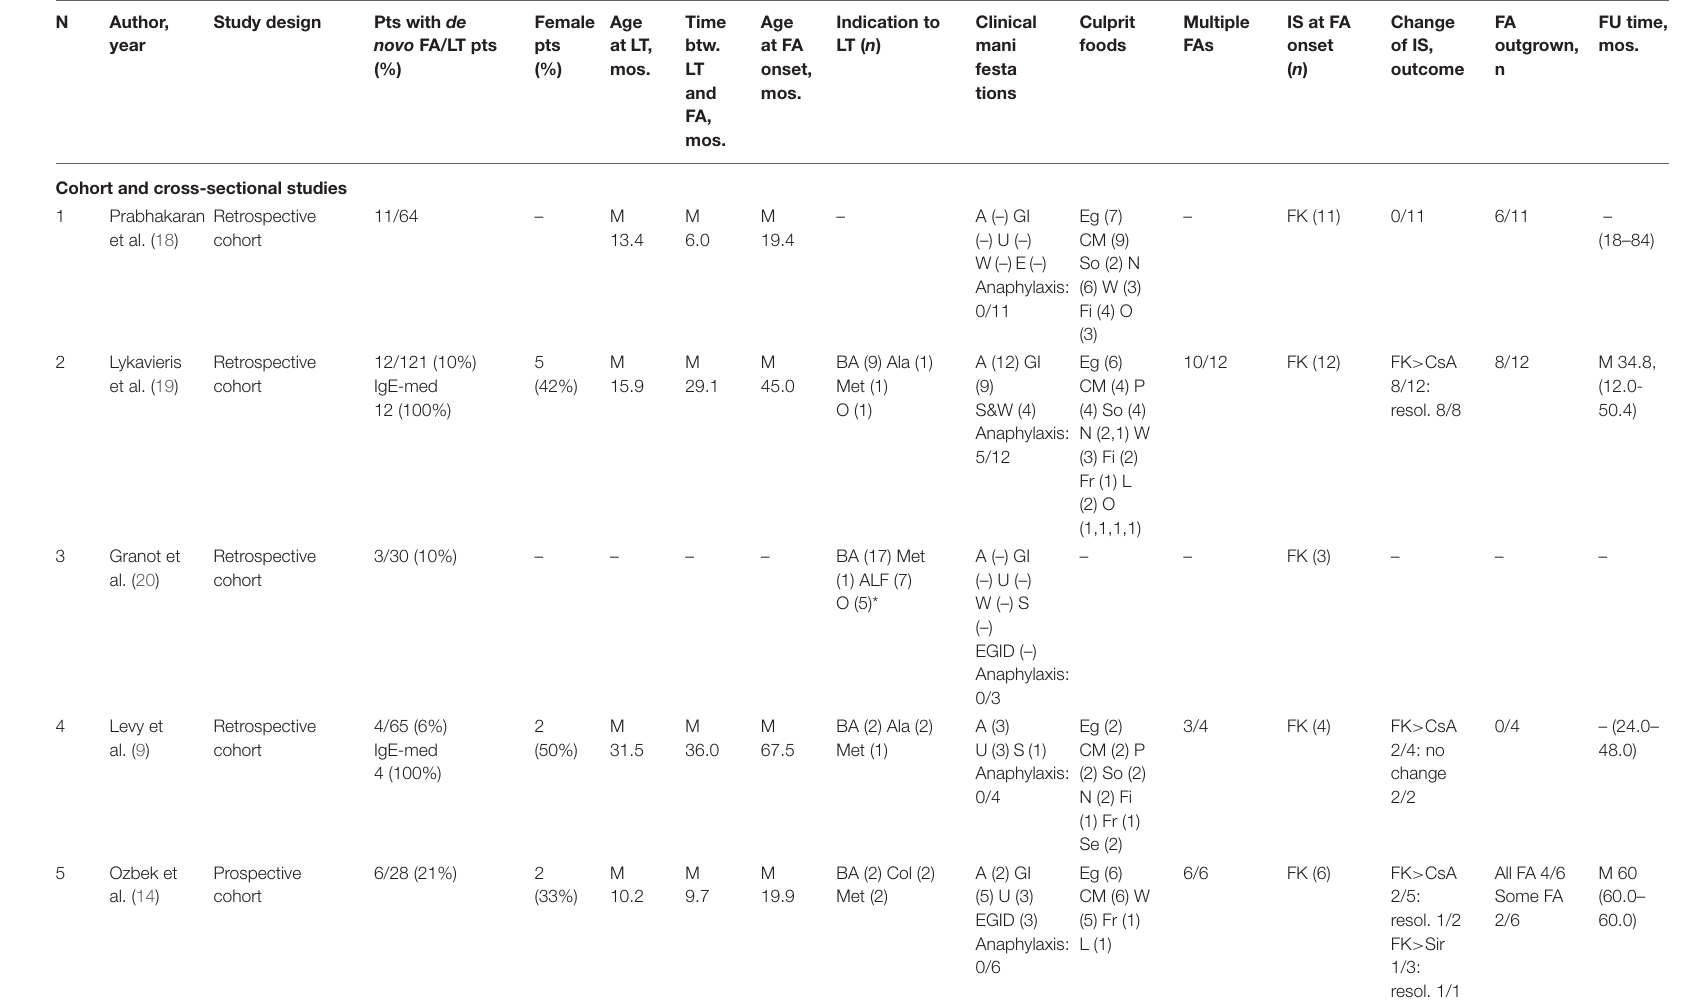
TABLE 1 | Raw data obtained from the 40 studies included in the systematic